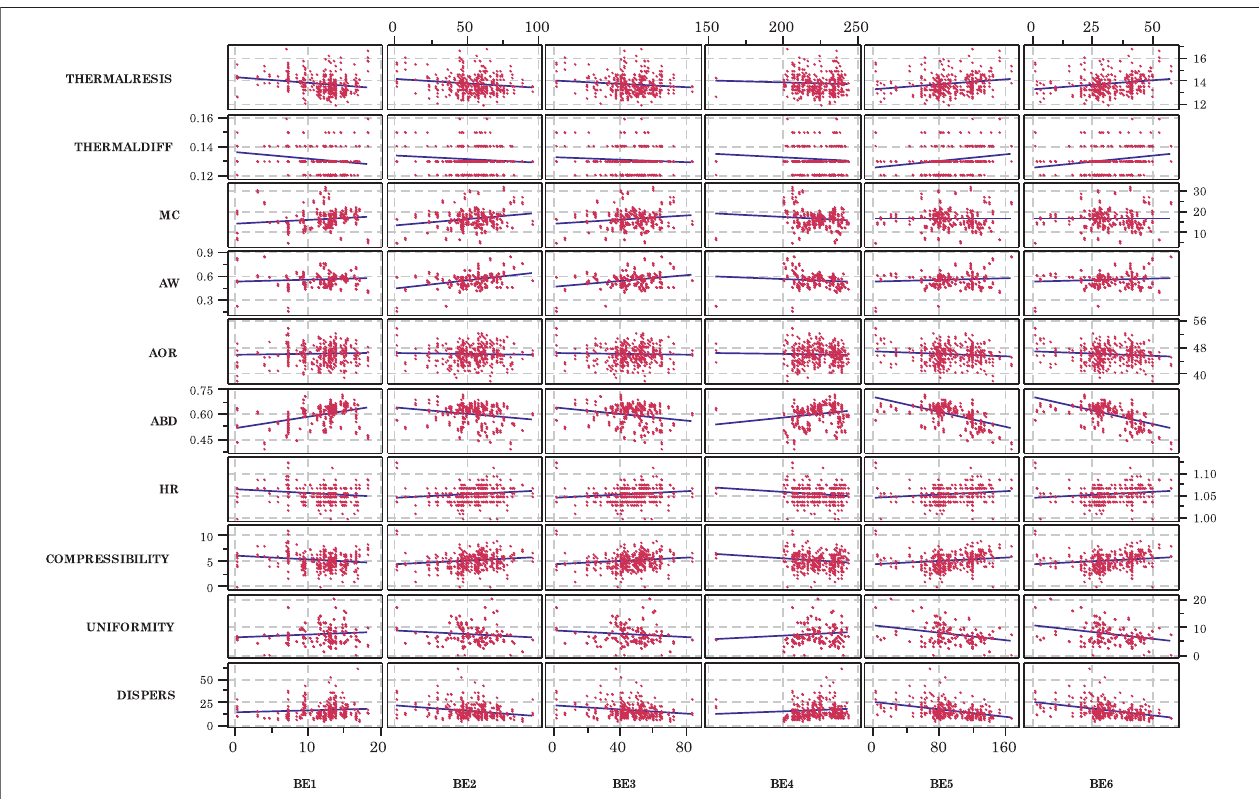
FIGURE 4 | Scatterplots of dependent variables for each back end independent variable. Although considerable scatter is present, some linear trends appear pronounced. Variable de fi nitions provided in Tables 1, 2 .